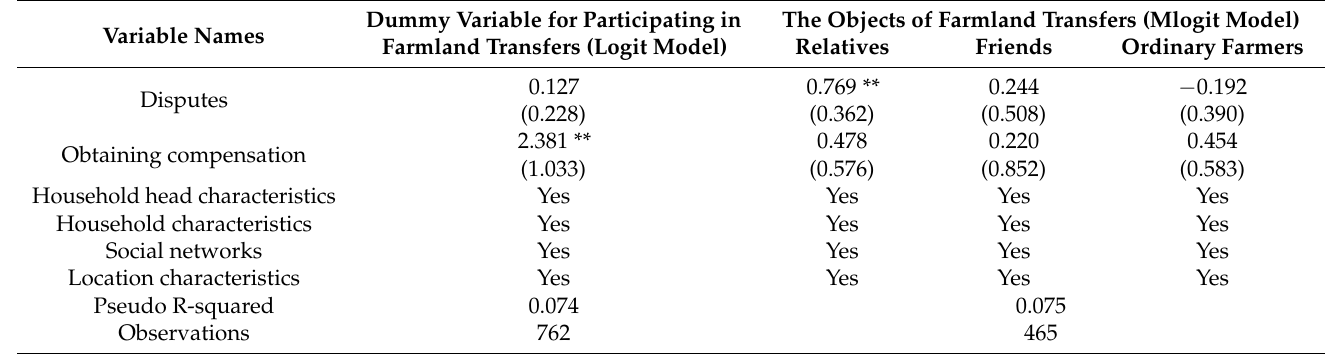
Table 8. Estimation results of the impact of the interactive item on farmland